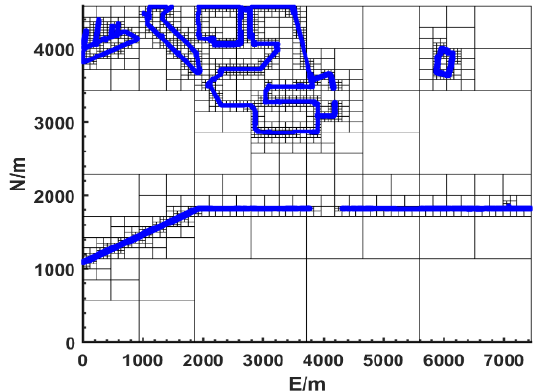
Figure 3. A part of Long Beach Harbor.